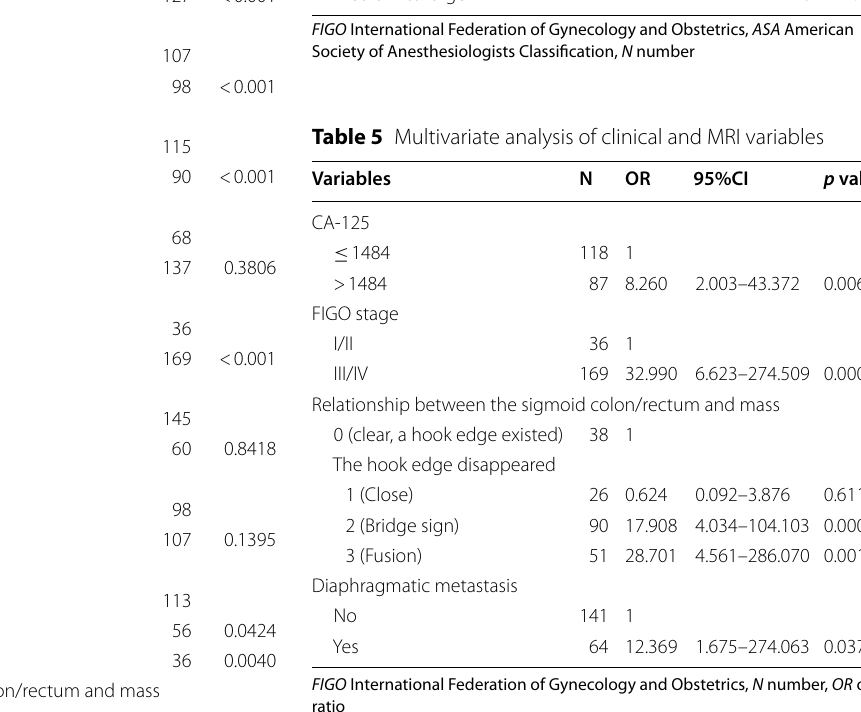
FIGO International Federation of Gynecology and Obstetrics, N number, OR odds